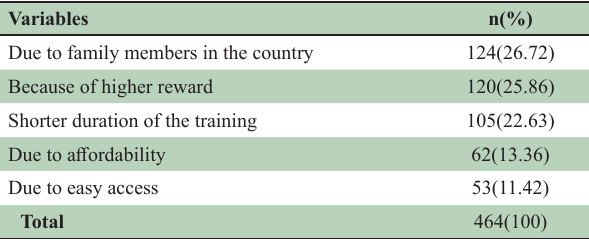
Table-I: Reasons for choosing a